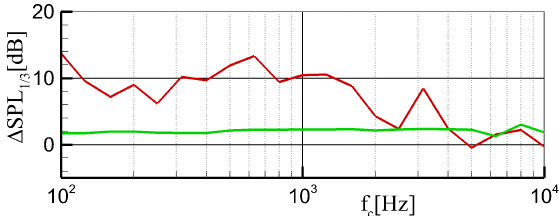
Figure 9. Predicted noise reduction spectra by the simulation approach for the VLCS configuration ( red ) and the porous slat cove liner ( green ) with respect to the F16 reference